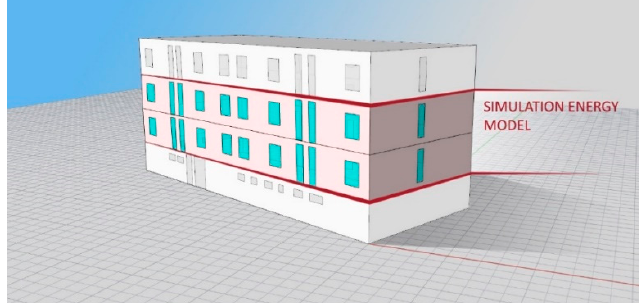
Figure 4. 3D view of the building model on Rhinoceros UI.